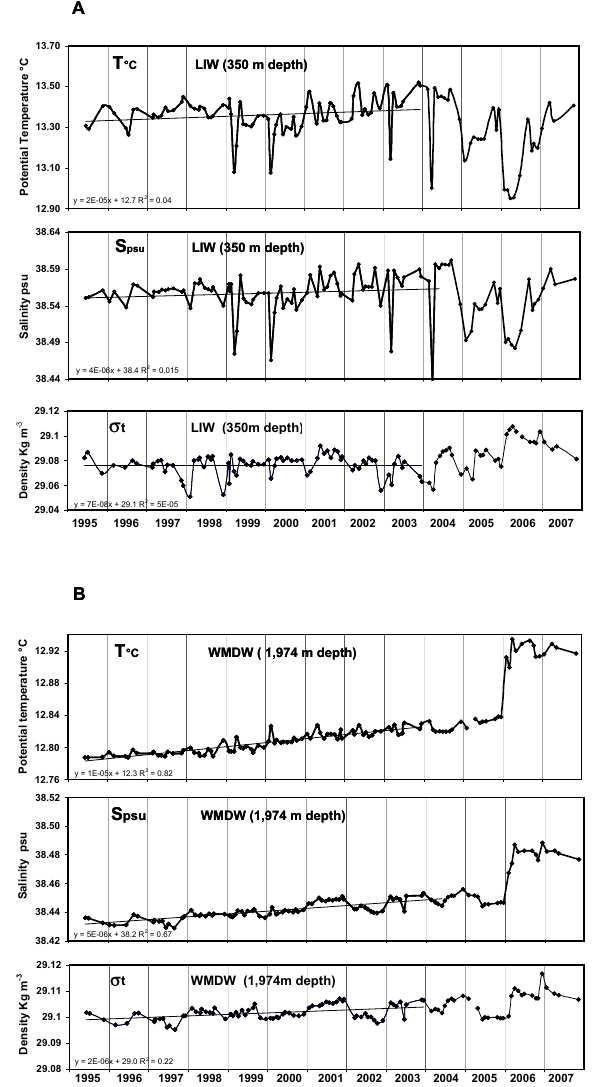
Fig. 4. (A) Potential temperature, salinity and density for LIW (350m depth) from 1995 to 2007. (A) Potential temperature, salin- ity and density for WMDW (1974m depth) for the same period. Regression lines have been drawn for 1995–2003